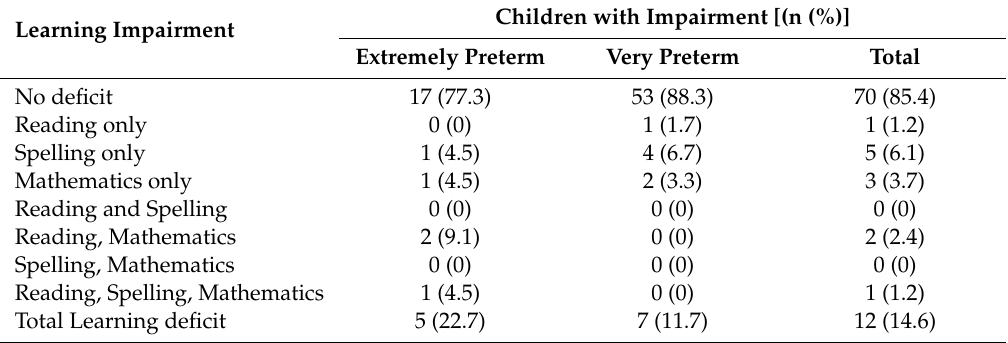
Table 7. Summary of the prevalence of the learning impairments and comorbidities in each of the groups of children (z-score cut-o ff , ≤−